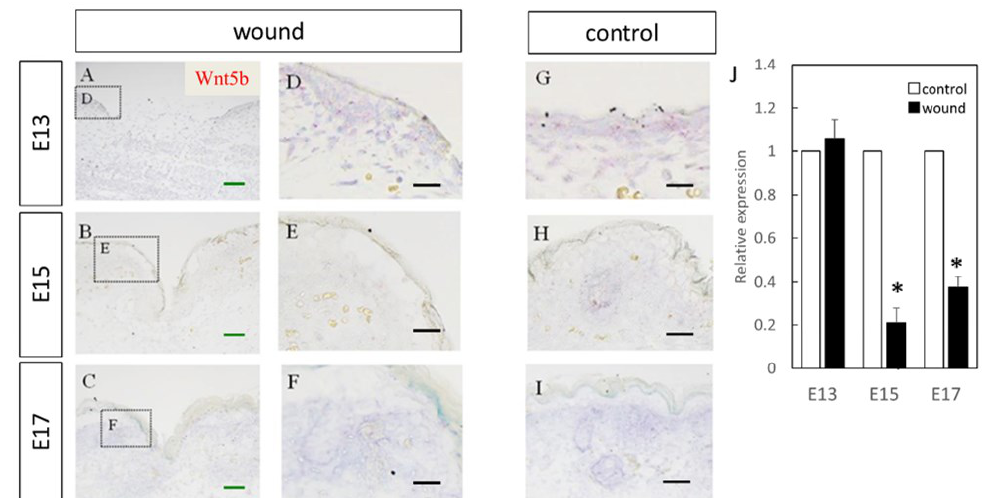
Figure 3. Measurement of Wnt5b expression in the wound by in-situ hybridization and real-time quantitative PCR. Wnt5a expression is indicated in red in the tissue. Wnt5b expression was confirmed in the dermal layer. Expression was increased in E13, but in E15 and E17, Wnt5b expression in the wound area was decreased compared to that in the normal areas. ( A – C ) Weakly magnified images of the region around the wound. ( D – F ) Strongly magnified images of the wound margin.